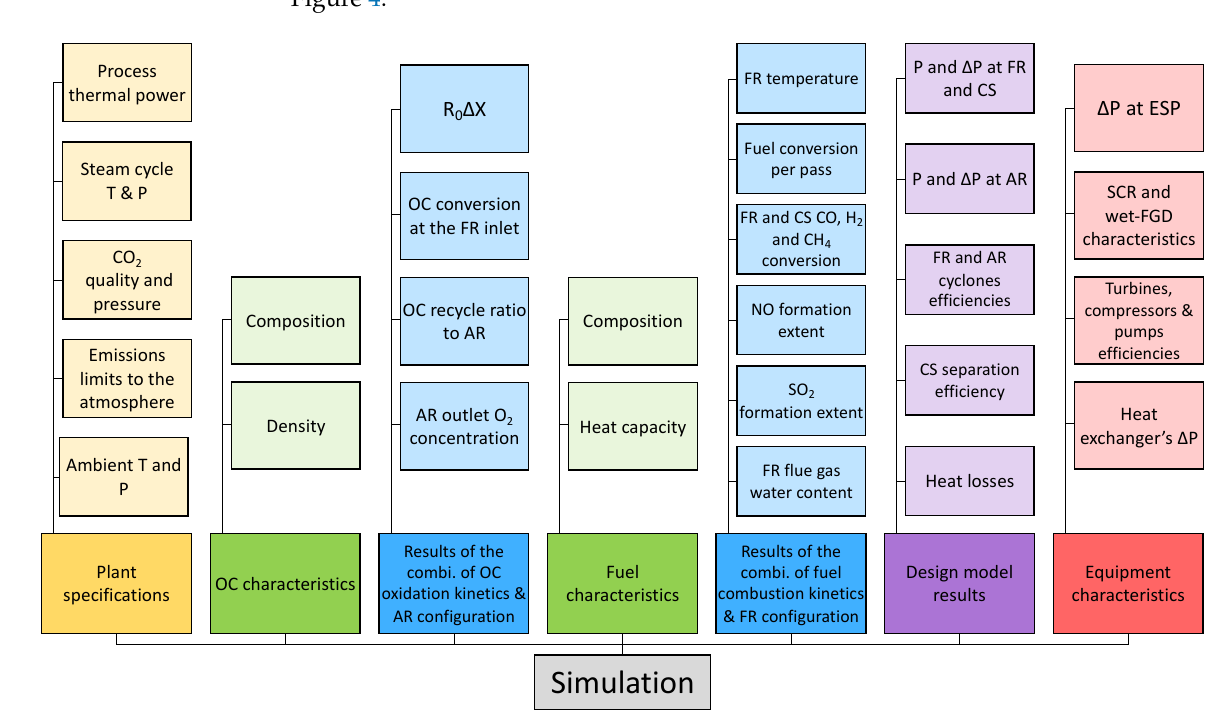
Figure 4. Classification of the model inputs.